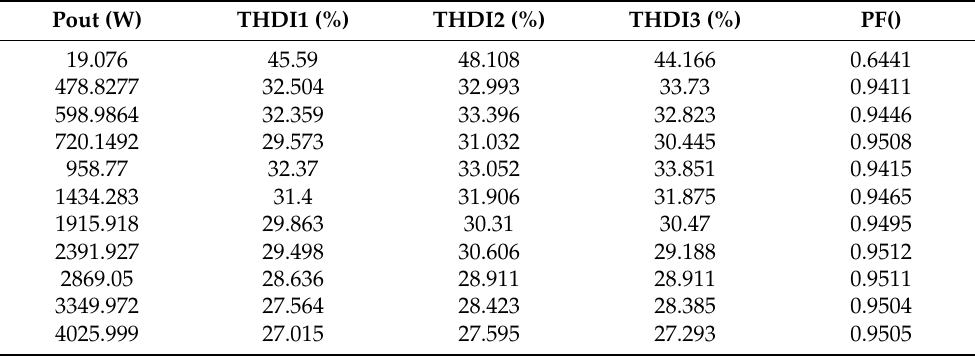
Table A5. THD and PF parameters for original transistor GaN IGT60R070D1 and ferrite